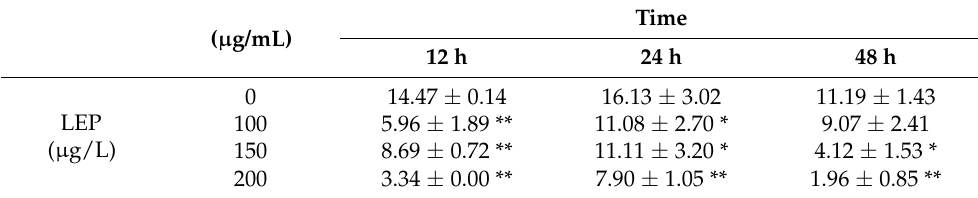
Table 12. Effect of different concentrations of GSP on LEP mRNA expression in mature adipocytes.